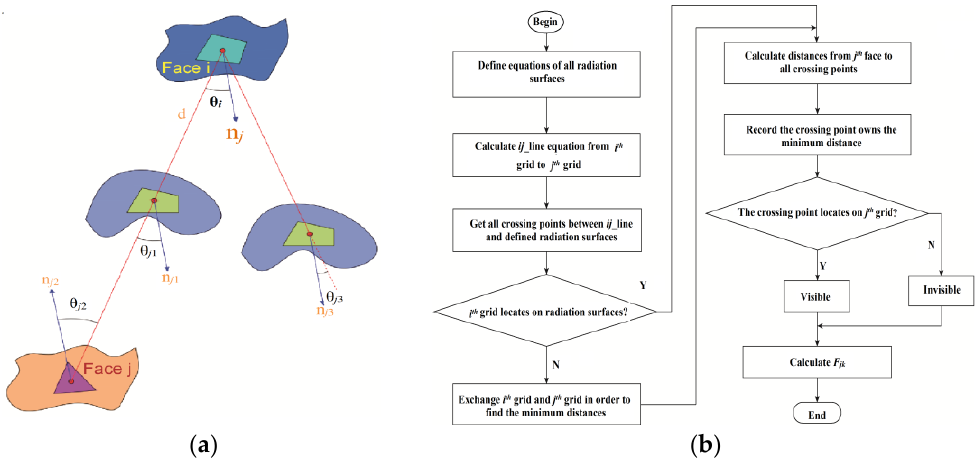
Figure 2. Diagram and flowchart for visible surface to surface radiation model. ( a ) Diagram; ( b ) flowchart.